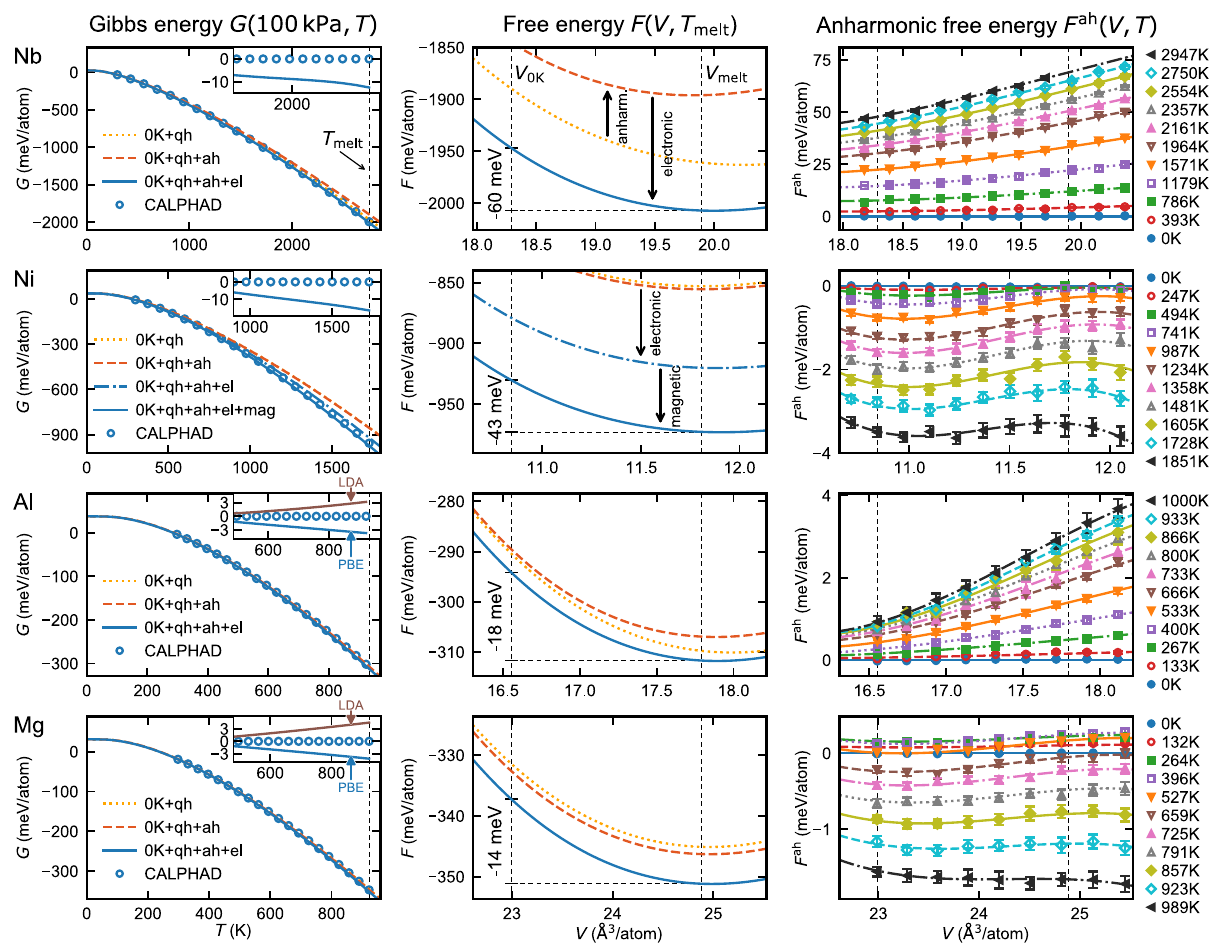
Fig. 5 Ab initio calculated thermodynamic potentials for Nb, Ni, Al, and Mg. Gibbs energy G ( T ) at 100 kPa ( fi rst column), free energy F ( V ) at T melt (second column), and anharmonic free energy F ah ( V , T ) (third column), using the PBE XC functional. The G ( T ) values are referenced to the minimum energy of the static lattice at 0 K. Calculations using the CALPHAD method 41 (aligned to the ab initio values at room temperature) are shown in blue dots for comparison. The insets contain the full ab initio Gibbs energy at high temperatures with respect to the CALPHAD values, with the results for LDA added for Al and Mg. For G ( T ) and F ( V , T melt ), curves including different excitation mechanisms are shown. The melting temperatures T melt correspond to experimental values. The error bars denote a 95% con fi dence